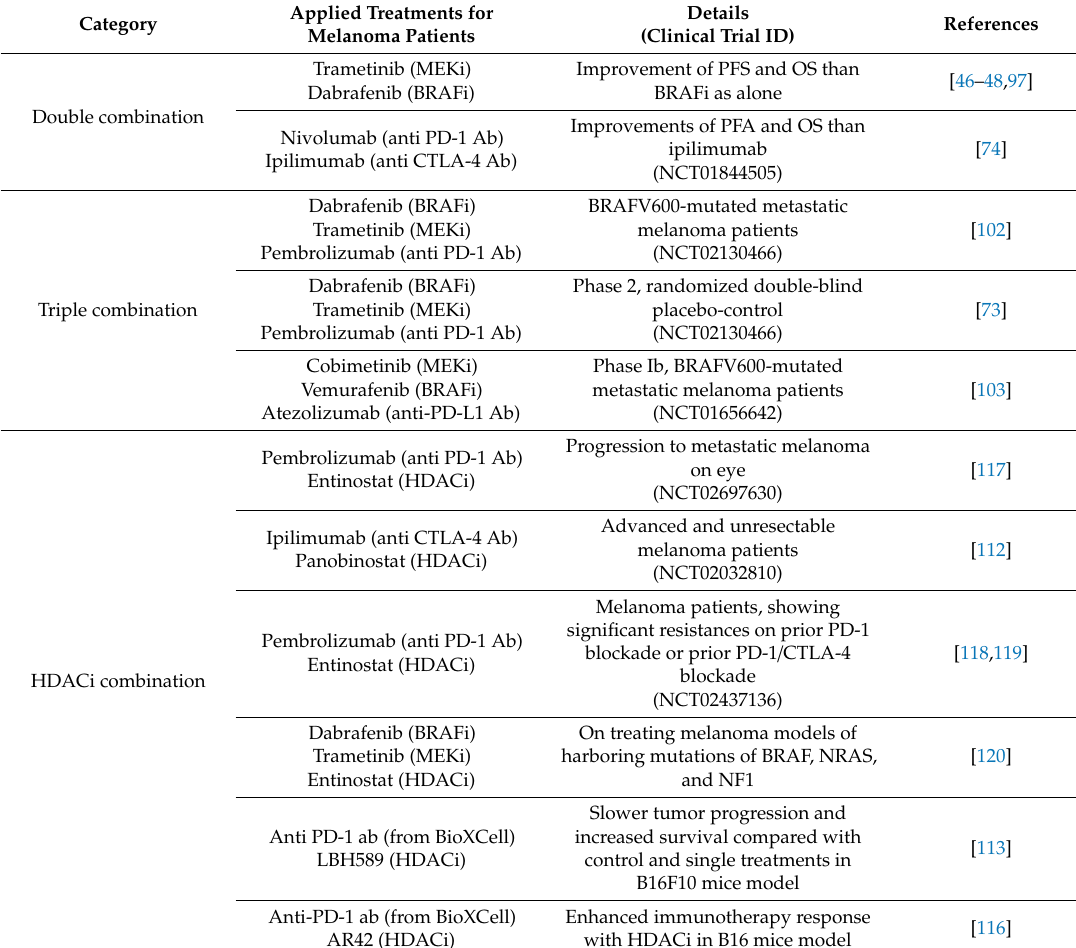
Table 3. Combinative treatments for metastatic